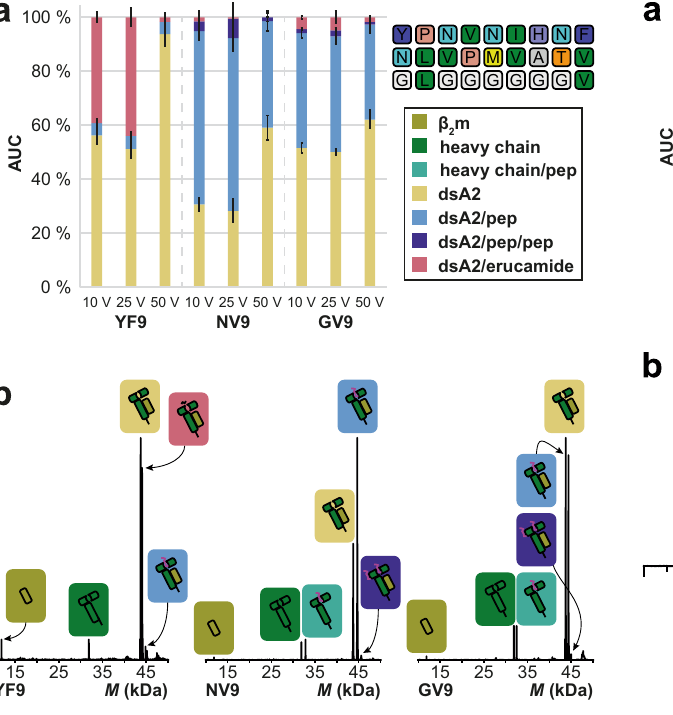
Fig. 2 Overall area under the curve (AUC) for the detected dsA2 mass species in presence of YF9, NV9, and GV9 at different acceleration voltages. a The AUC is determined over the entire spectrum for the respective mass species at 10, 25, and 50V. The cone voltage is kept constant at 150 V. The mean value of the AUC in the absence or presence of the different peptides (protein – peptide ratio 1:5) from at least three independent measurements is depicted along with error bars that represent the corresponding standard deviation. “ dsA2 ” corresponds to the empty HLA-A*02:01(Y84C/A139C) disul fi de mutant complex, “ dsA2/pep ” to dsA2 bound to one peptide, “ dsA2/pep/pep ” to dsA2 bound to two molecules of this peptide, and “ dsA2/erucamide ” to dsA2 bound to erucamide, respectively. The negative control YF9 barely associates with dsA2, whereas the positive control shows a high proportion of dsA2/NV9, indicating high af fi nity. GV9, which contains only the two anchor residues Leu-2 and Val-9 of NV9, still shows a high af fi nity, and at 50V, their dsA2/pep proportions are very similar, showing that their gas-phase stability is comparable. b Representative charge-deconvoluted spectra of the distinct protein and protein – peptide complex species recorded at 25V. Olive and dark green correspond to the free β 2 m domain and heavy chain, respectively. Teal corresponds to a free heavy chain still attached to a peptide. The different complexes are assigned in yellow (empty dsA2), coral (dsA2/erucamide), light blue (dsA2/pep), and dark blue